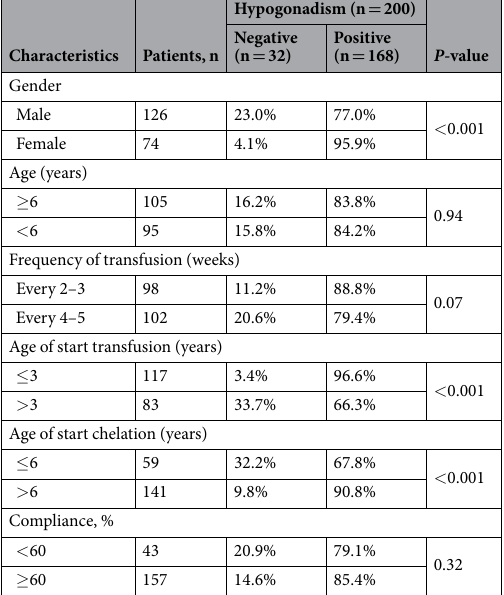
Characteristics Patients, n